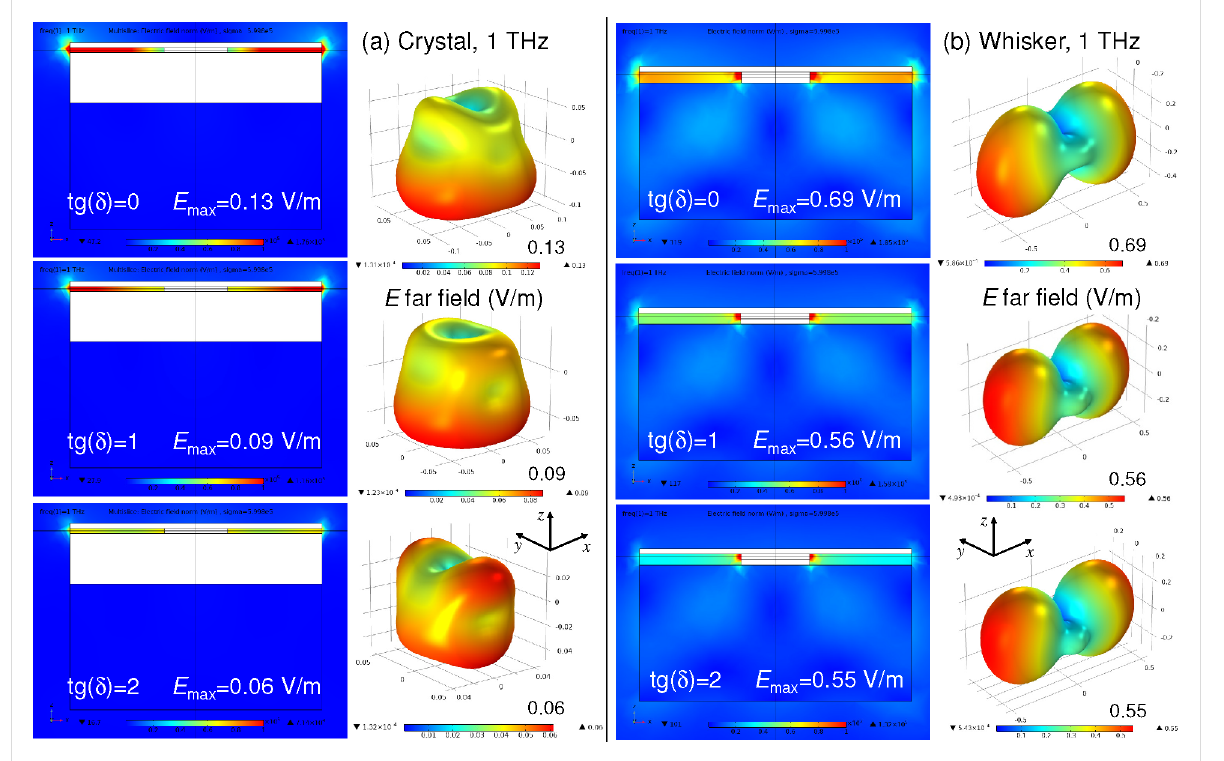
Figure 7: Variation of radiative properties with increasing dielectric losses tan( δ ) = 0 (top row), 1 (middle row), and 2 (bottom row) for (a) crystal- based (two leftmost columns) and (b) whisker-based devices (two rightmost columns). Simulations are made at f = 1 THz. Note a rapid suppression of the far-field amplitudes in crystal-based